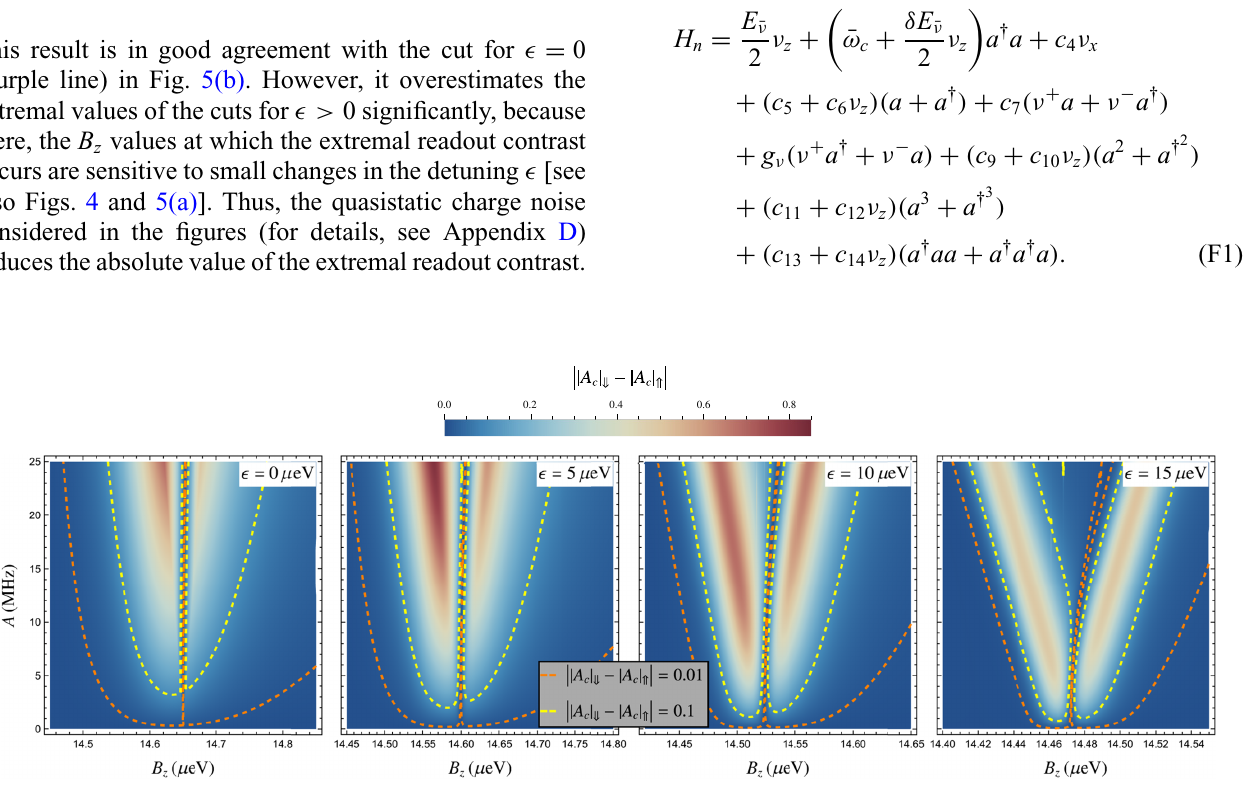
FIG. 10. Absolute value of the readout contrast as a function of the hyperfine interaction strength A and the homogeneous magnetic field B z for four values of the detuning (cid:2) . The remaining parameters are as in Fig. 4. For the QD-donor system studied in this paper, we have A = 25